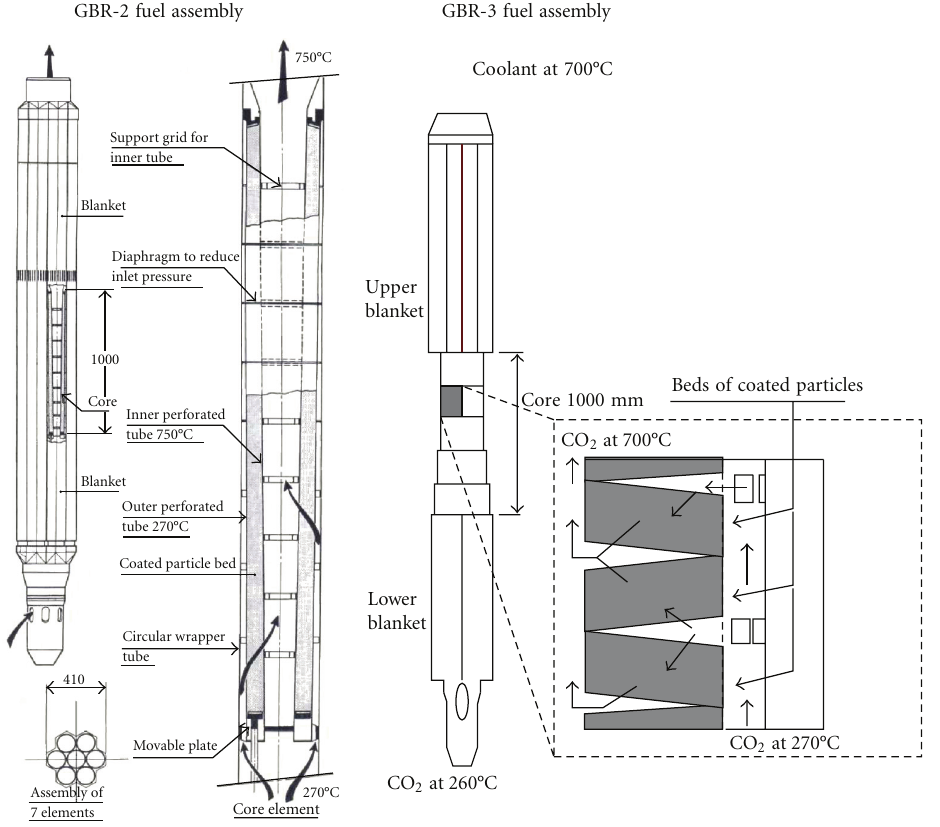
Figure 4: Fuel assemblies for GBR-2 (left) and GBR-3